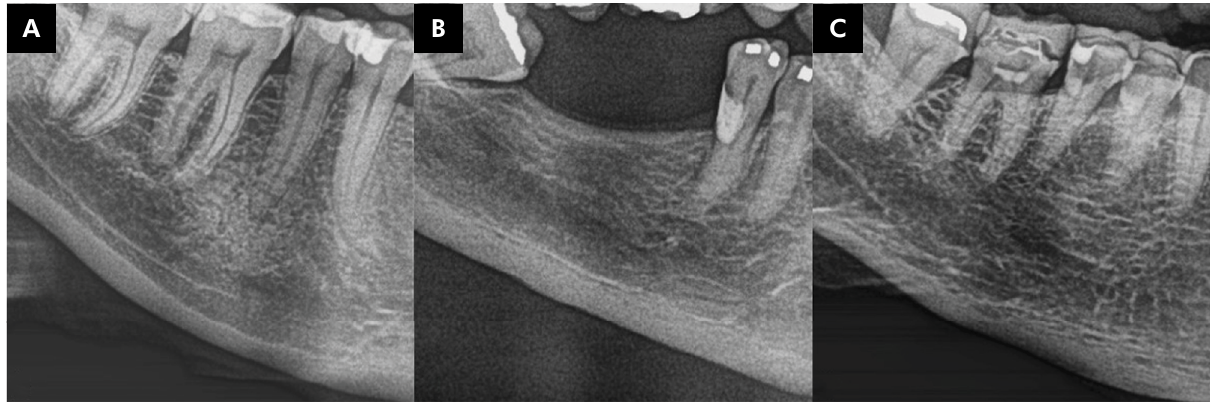
Figure 1. The mandibular cortical index (MCI) is visualized from the region of the mental foramen to the third molar region. (A) Mandibular cortical bone without erosion, when the cortical endosteal margin was normal on both sides, is classified as C1. (B) Mandibular cortical bone with erosions in the superficial portion, when semilunar defects occur in the endosteal margin on one or both sides, is classified as C2. (C) A porous mandibular cortical bone, when more than two-thirds of the height of the mandibular cortex have been affected, is classified as